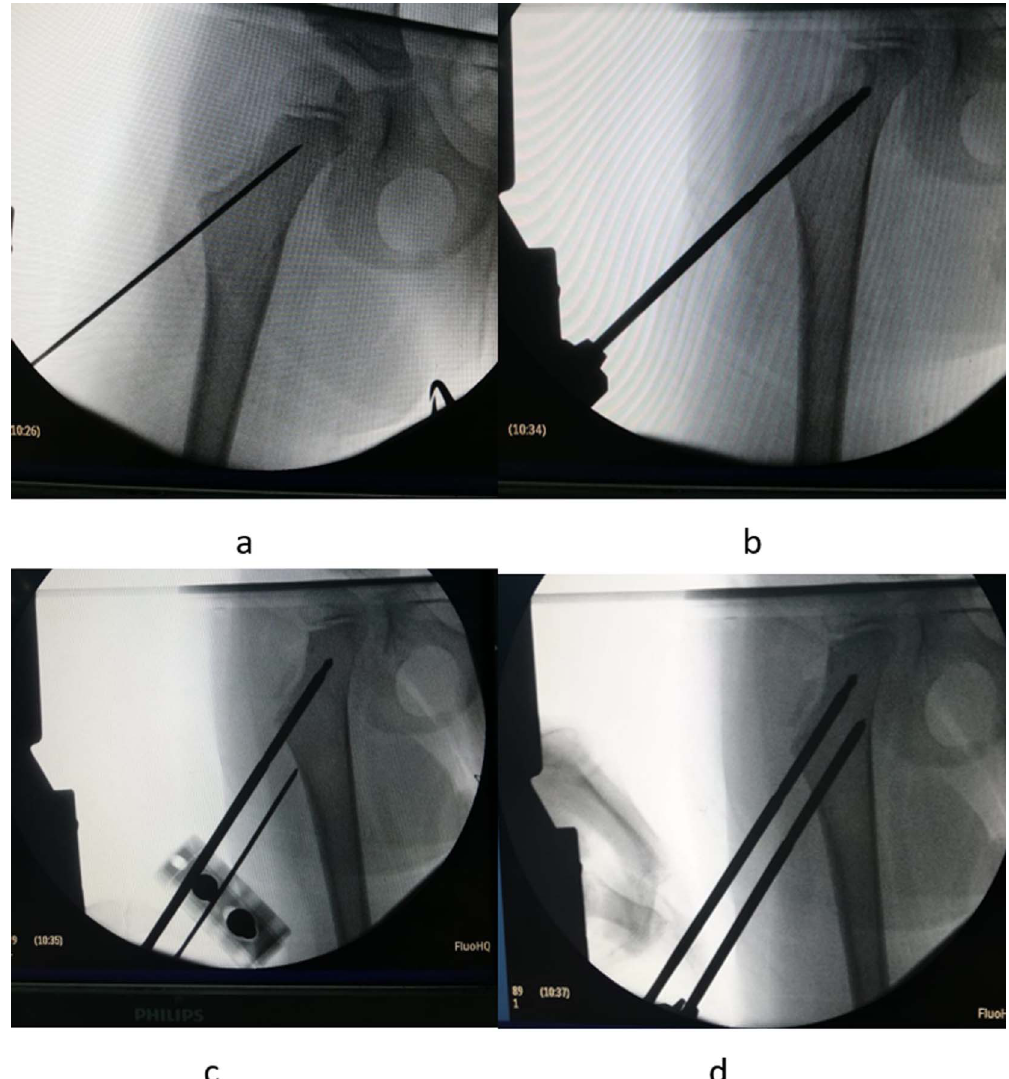
Figure 1. Proximal pins insertion: a K-wire is inserted in the uppermost region of the neck (a), which is replaced then by a pin (b). The second pin is inserted parallel using the external fi xator clamp as a template (c,